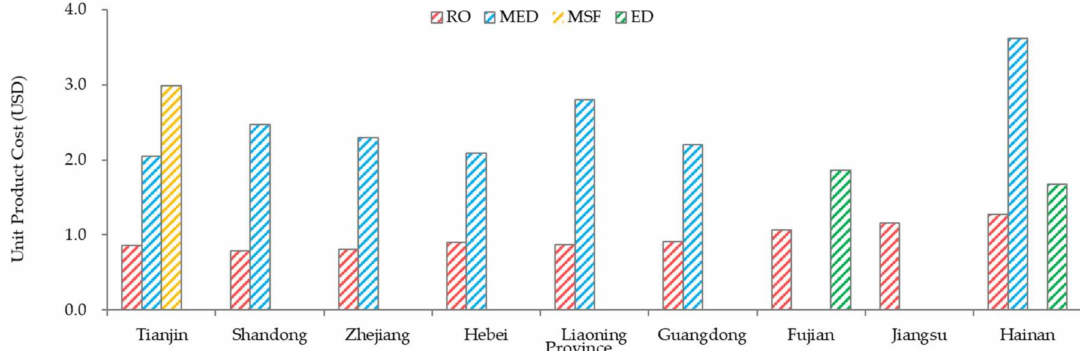
Figure 8. Unit product cost of water desalination by province in